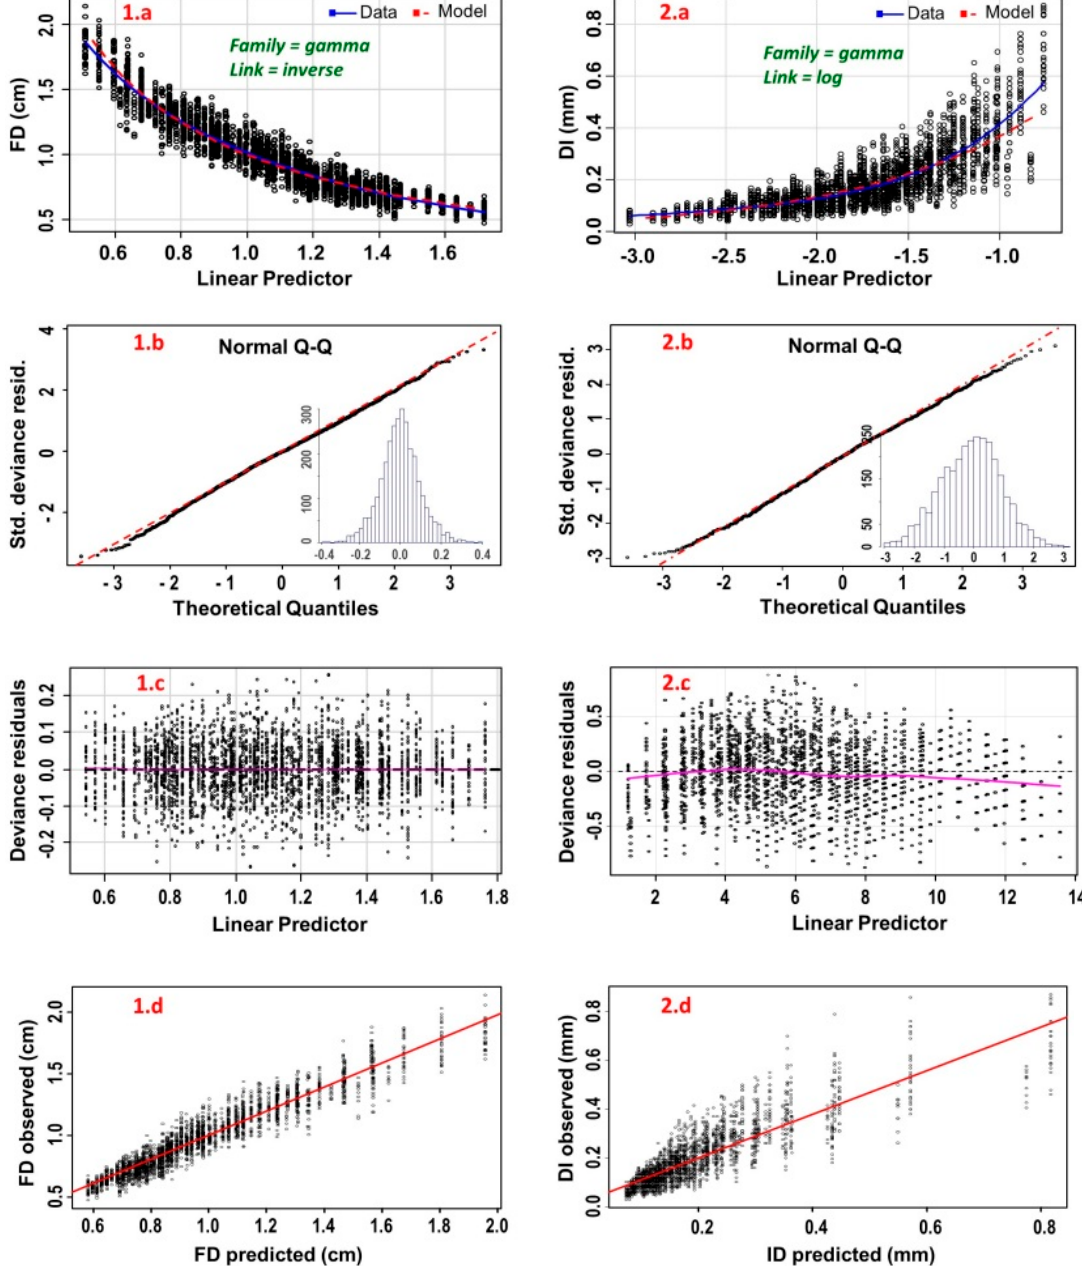
Figure 5. General diagnostic. 1. footprint diameter (FD); 2. indentation depth (ID); ( a ): Marginal model; ( b ): Residual normality; ( c ): Deviance residuals against the linear predictors; ( d ): Observed vs. predicted.